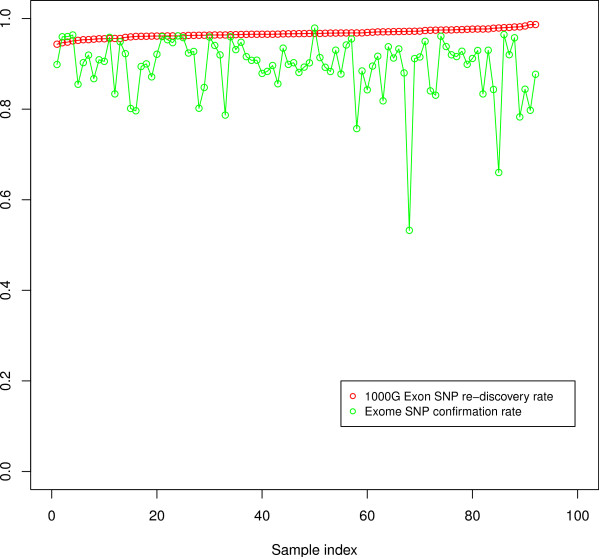
Comparison of 92 1000 Genomes Exome samples to Exome Pilot Data. We made SNP calls using the Atlas2 Suite on 92 samples from 1000 Genomes Phase 1 Exome project, and compared the result to the most recent release from the 1000 Genomes Exon Pilot project. The Atlas2 re-discovery rate was calculated for each sample (red). The average re-discovery rate is 96.7%. An average 89.5% of the SNPs called by Atlas2 were confirmed in the Exon Pilot project (green). The exome SNPs called by Atlas2 but not called in 1 KG Exon pilot is either due to Exon pilot's limited sensitivity or false discovery in Atlas2.